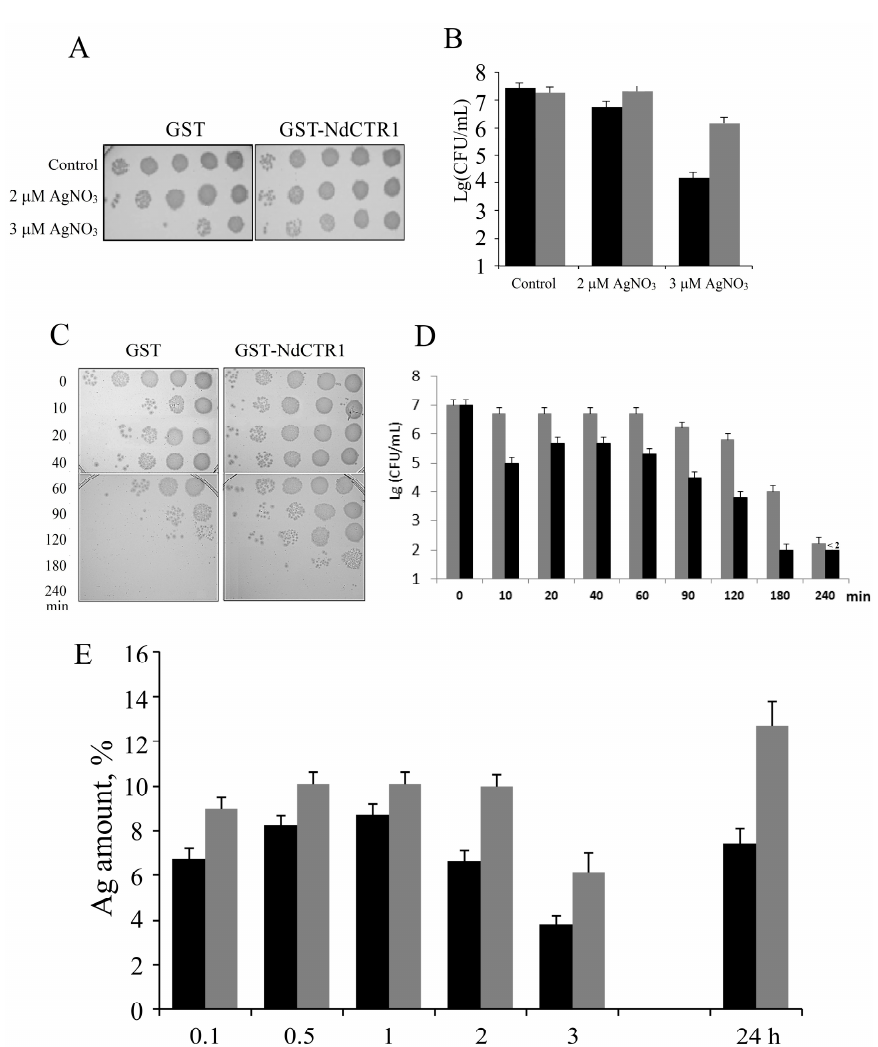
Figure 3. ( A ) Effect of silver ions on E. coli Bl21(DE3)/pGEX-4T-1 and BL21(DE3)/pNdCTR1 after 24 h of treatment (protocol of the experiment). ( B ) Bar graph corresponding to the ( A )